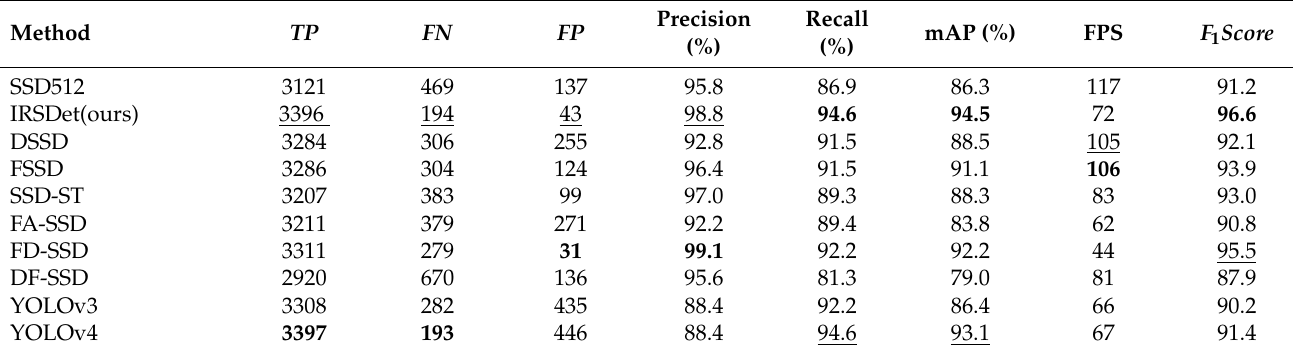
Table 4. Comparison of different detection